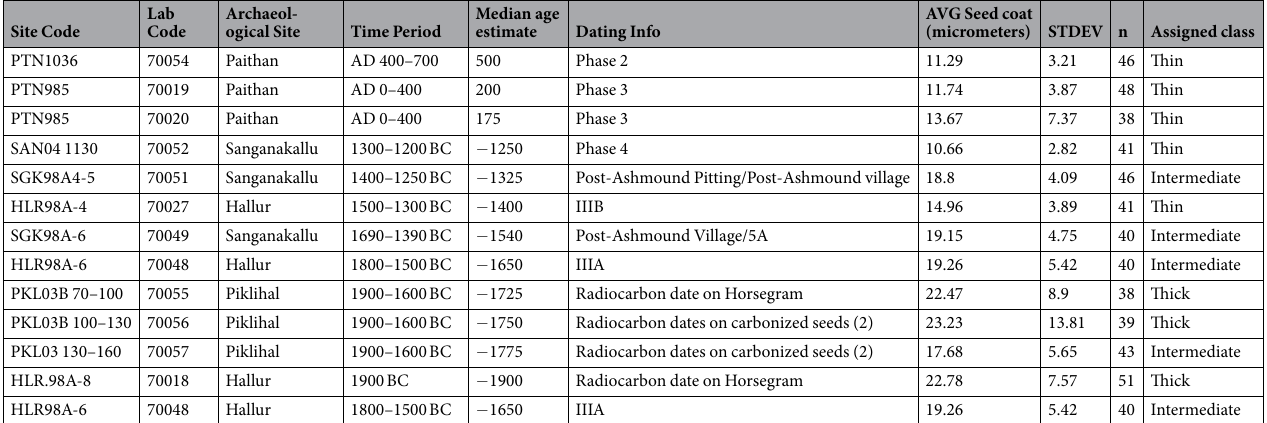
Table 3. Summary of testa thickness measurements on HRXCT images of archaeological horsegram specimens obtained by synchrotron imaging. Raw measurements in Table